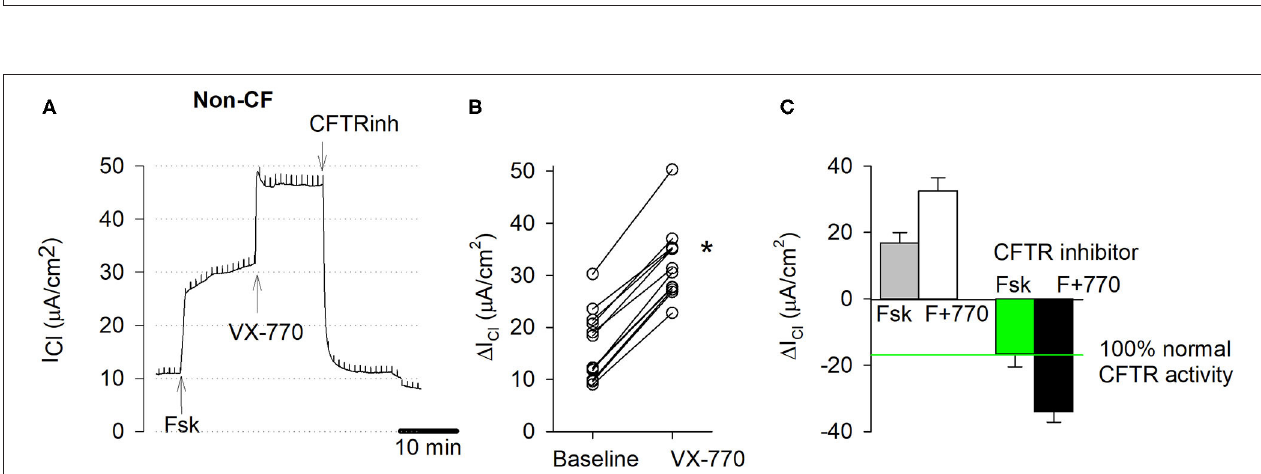
FIGURE 4 | CFTR function measurements in EpiX TM -expanded non-CF cultures. Normal bronchial epithelial cells, one donor, passage 1. (A) Original short circuit current trace, untreated. Transepithelial chloride current (I Cl ) was recorded in presence of amiloride. Stimulation of wildtype CFTR currents by the cAMP agonist forskolin (20 µ M, serosal) and CFTR potentiator VX-770 (1 µ M, mucosal) and subsequent inhibition by CFTR inhibitors (CFTRinh-172, PPQ-102, GlyH-101; 50 µ M, mucosal). Note, trace does not show initial amiloride and final ATP additions. (B) Individual responses. Baseline represents change in cAMP-dependent CFTR current by forskolin alone. VX-770 represents change in current by forskolin + VX-770. * denotes significant increase by VX-770 (paired t -test, p < 0.05, n = 12). (C) CFTR-specific currents represent change in current due to stimulation by forskolin (cAMP) and VX-770 (upward bar) and total inhibition of cAMP-stimulated and cAMP + VX-770 stimulated CFTR currents by CFTR inhibitors (downward bar). Note that 100% normal CFTR activity is defined as the blocked forskolin-stimulated CFTR activity. Bars represent mean ± SE ( n = 12).